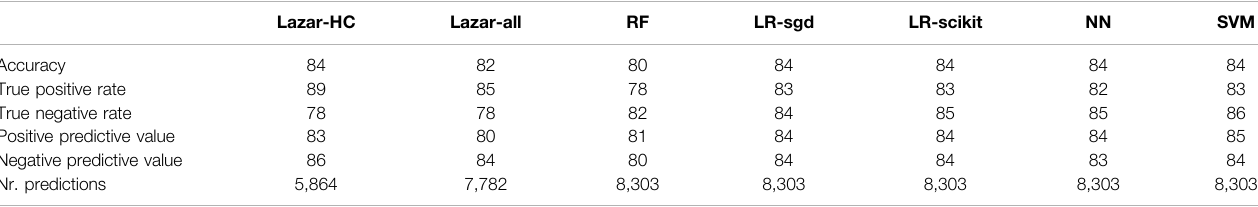
TABLE 1 | Summary of crossvalidation results with MolPrint descriptors (lazar-HC, lazar with high con fi dence, lazar-all, all lazar predictions, RF, random forests, LR-sgd, logistic regression (stochastic gradient descent), LR-scikit, logistic regression (scikit), NN, neural networks, SVM, support vector machines). Lazar-HC Lazar-all